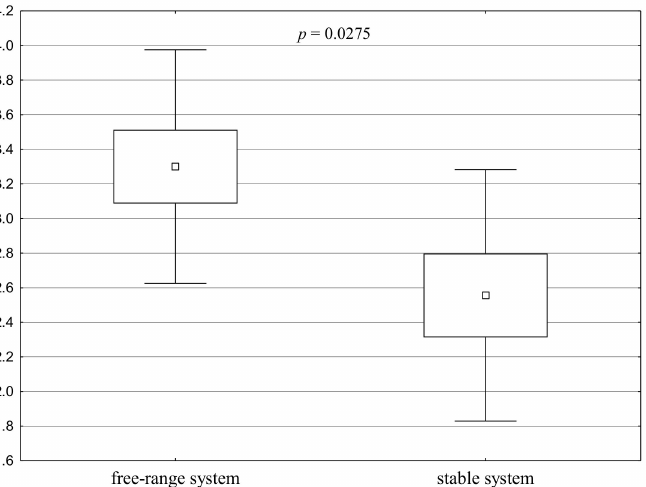
Figure 3. Distribution of Test 2 results for the groups - Active human test, stage 2.3: points for stroking the muzzle (a square shows the mean, a box corresponds to the range of the mean ± standard error, and “whiskers” show the range of the mean ± standard deviation). A significant difference between the groups is confirmed by the value of p <